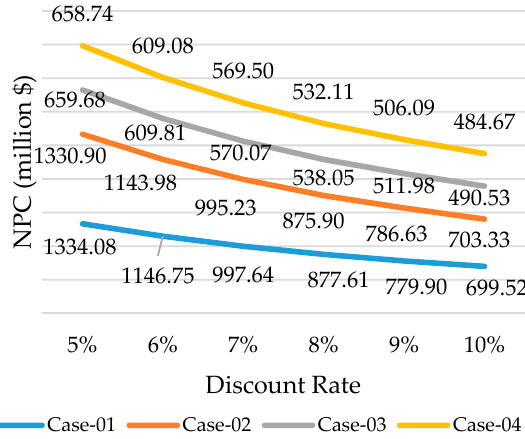
Figure 14. Sensitivity Assessment of Discount Rate on NPC.